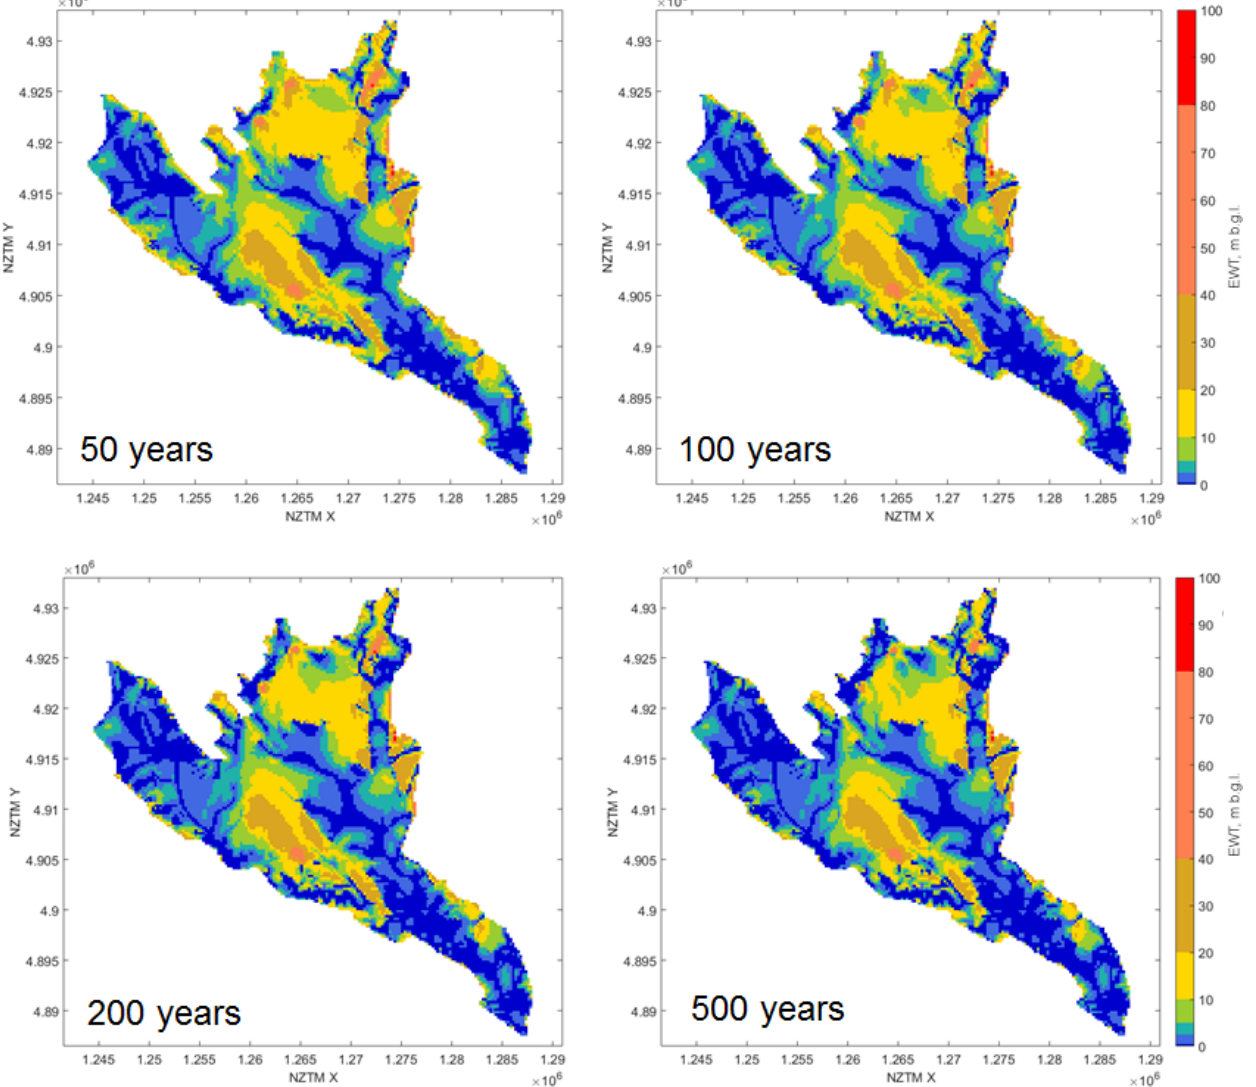
Figure B4. Convergence test in the Mataura catchment, Southland, New Zealand, with model runtimes of 50, 100, 200, and 500